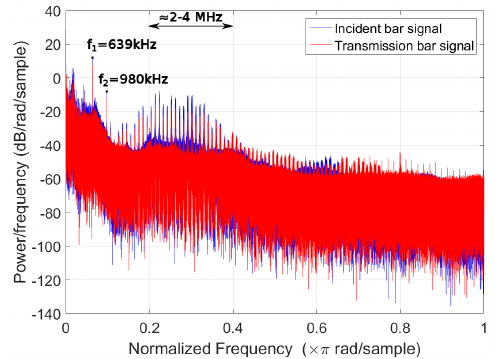
Figure 5. Periodogram of incident and transmission signal: l s = 500 mm (long striker), v s = 20 . 85 ms − 1 (low striker velocity)